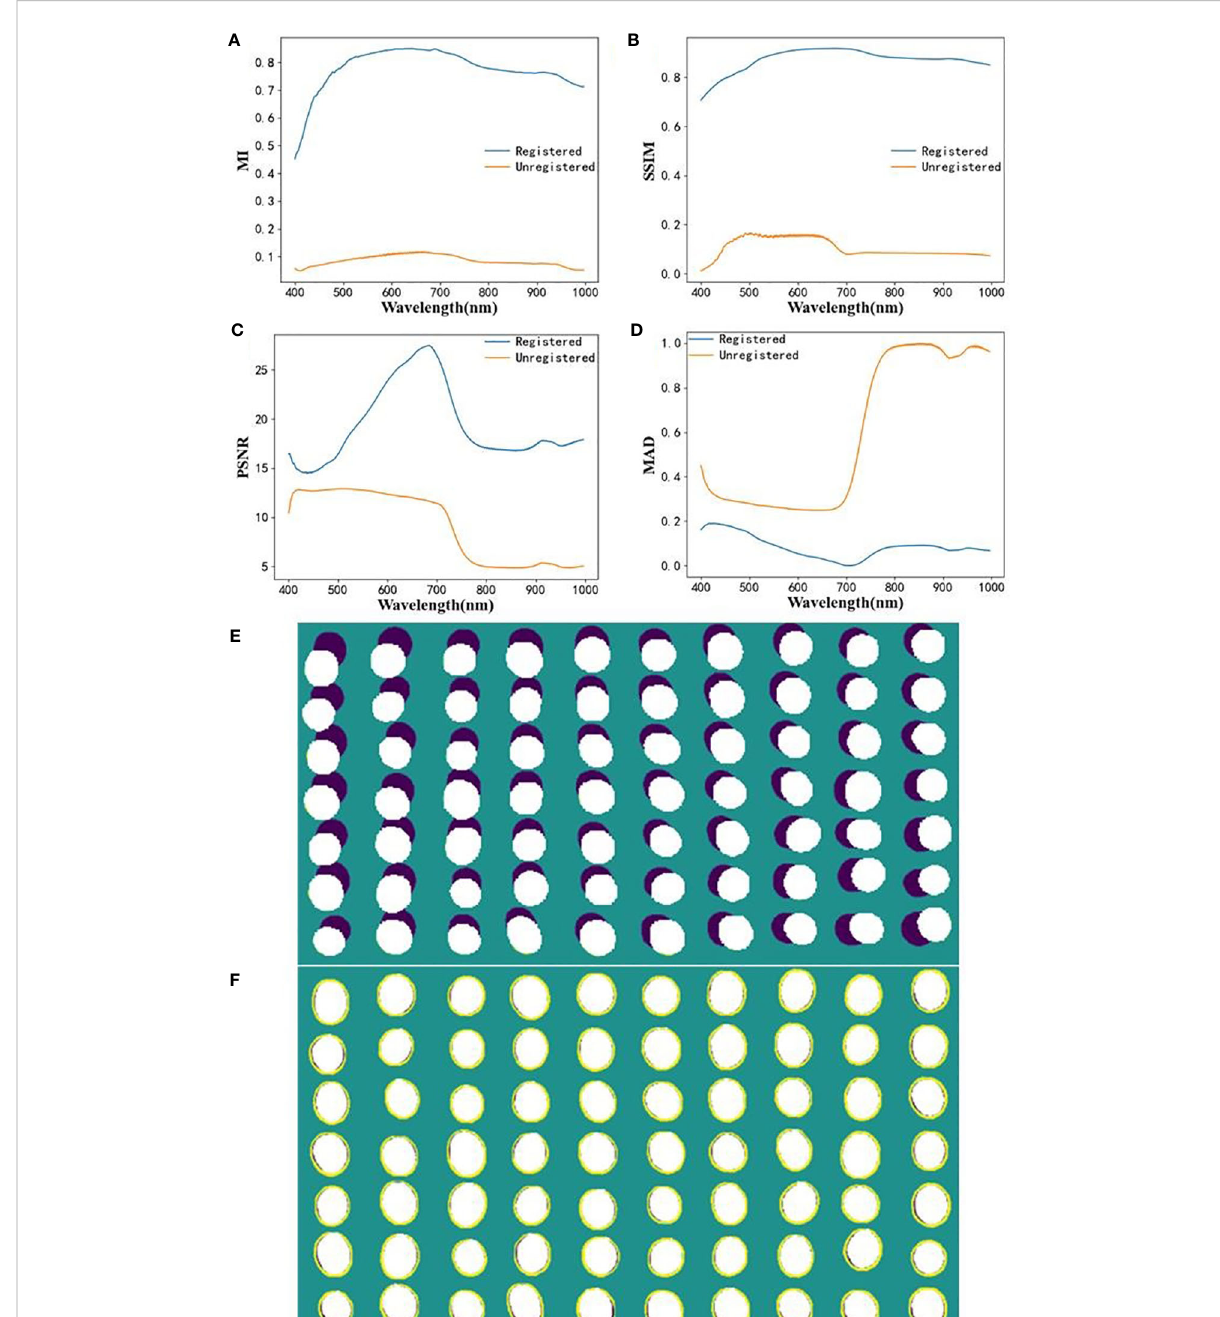
FIGURE 4 Evaluation results of HSI and RGB registration. (A) MI; (B) SSIM; (C) PSNR; (D) MAD; (E, F) visualization of image pairs before and after